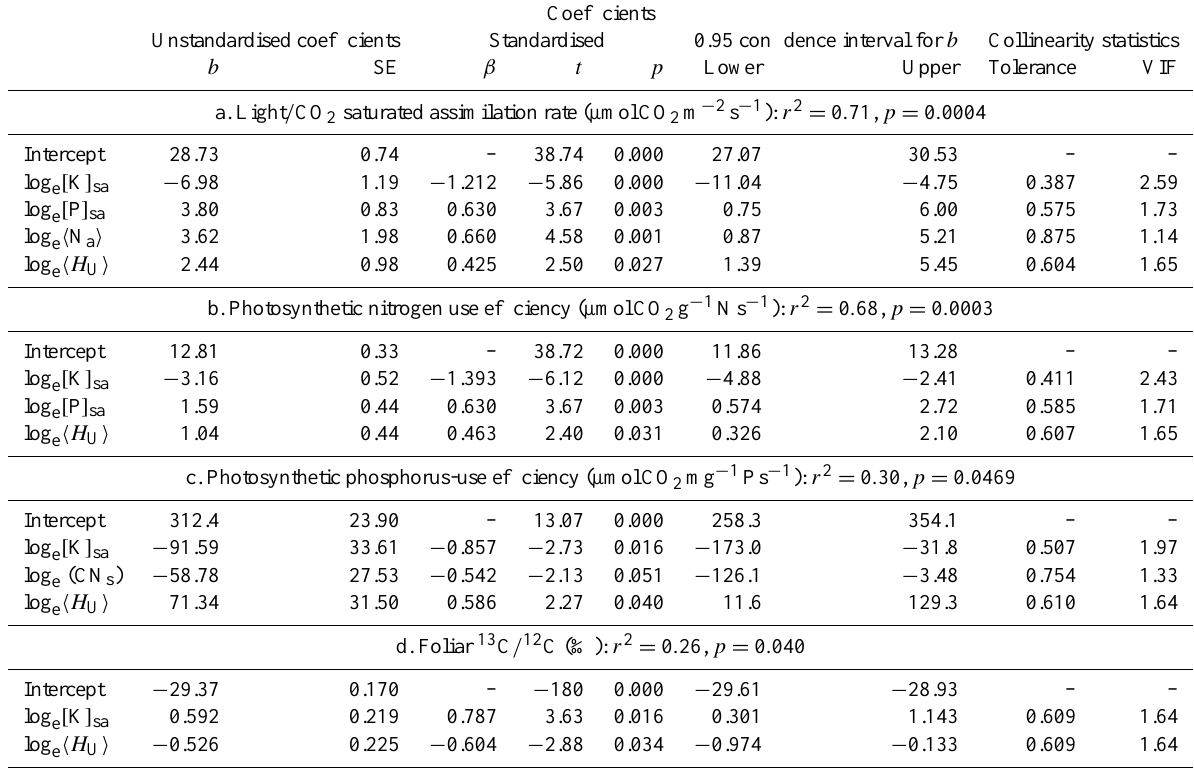
Table 2. Multivariate regression statistics relating estimates of community-weighted canopy-level average maximum CO 2 assimilation rates, nitrogen use efficiency, phosphorus-use efficiency and foliar 13 C / 12 C to canopy and soil variables. Abbreviations: [ K ] sa – soil potassium (mmolm − 2 ), [ P ] sa (µmolm − 2 ), (cid:104) N a (cid:105) – species-abundance-weighted area-based leaf nitrogen (gm − 2 ), (cid:104) H U (cid:105) – average canopy height (trees > 0 . 1m diameter at beast height, in m), CN s – soil CN ratio (gg − 1 ) and VIF – variance inflation factor. In all cases predictor variates have been centred with the unstandardised intercept giving then the predicted value when all predictor variables are at their mean values. In the standardised case, all variables have been centred and scaled by their